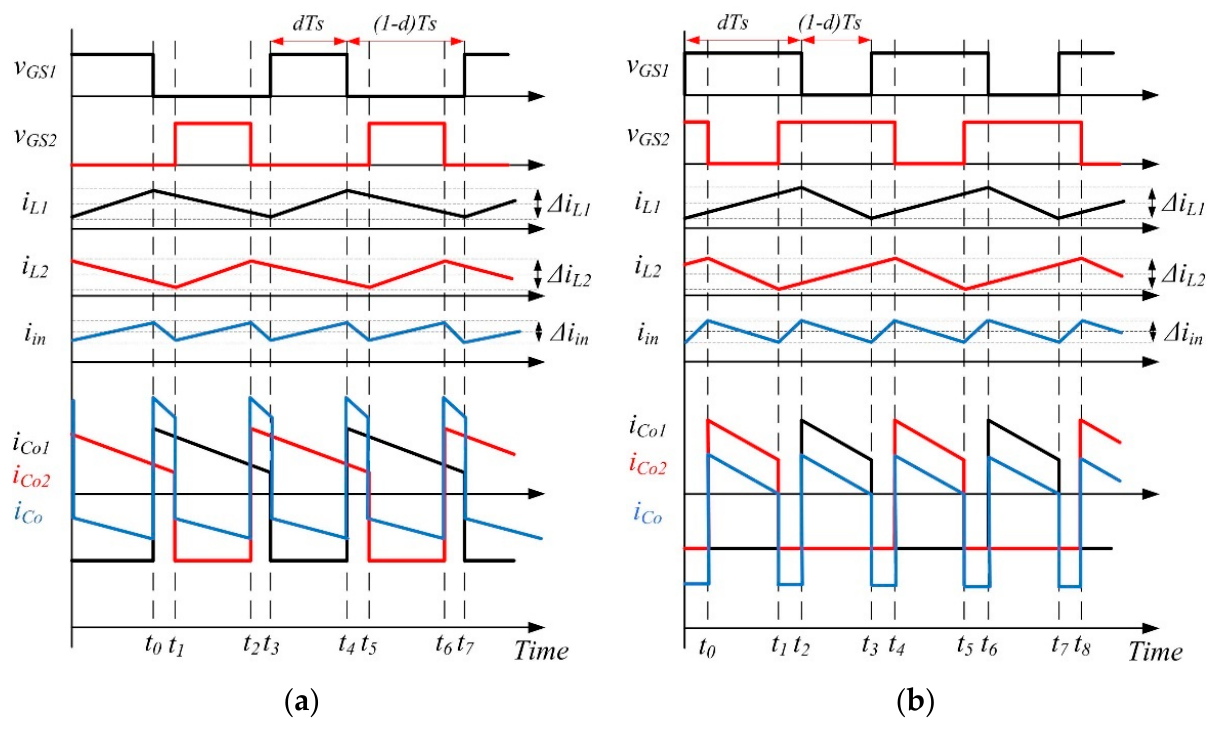
Figure 2. Waveforms of two − phase interleaved boost converter: ( a ) d ≤ 0.5; ( b ) d > 0.5. The IBC benefits from ripple cancellation and reduced input current ripple in both duty cycle operation modes, as shown in Figure 2a. The ripple rate of the output capacitor current becomes zero in this case. The rising slope of the input current in the d < 0.5 switching condition is equal to the rising time of any of the L 1 and L 2 inductors at dT s duration. The ripple rate of input current ∆ I in is calculated as the difference between